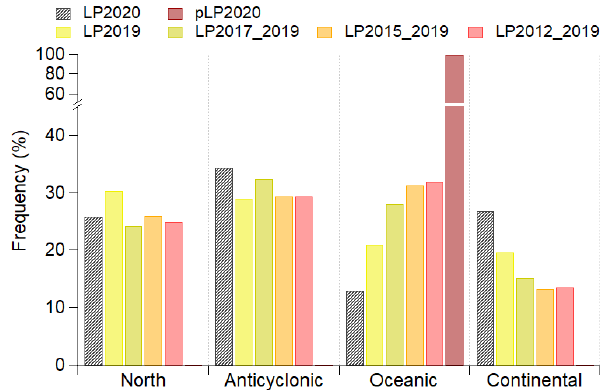
Figure 2. Frequency of trajectory clusters for each LP